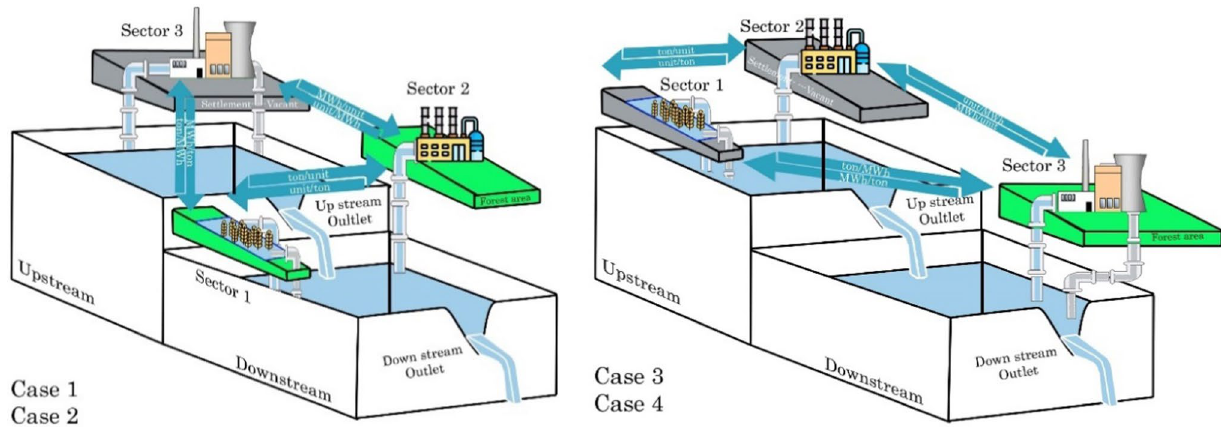
Fig. 4 Dividing the watershed into upstream and downstream sub-watersheds